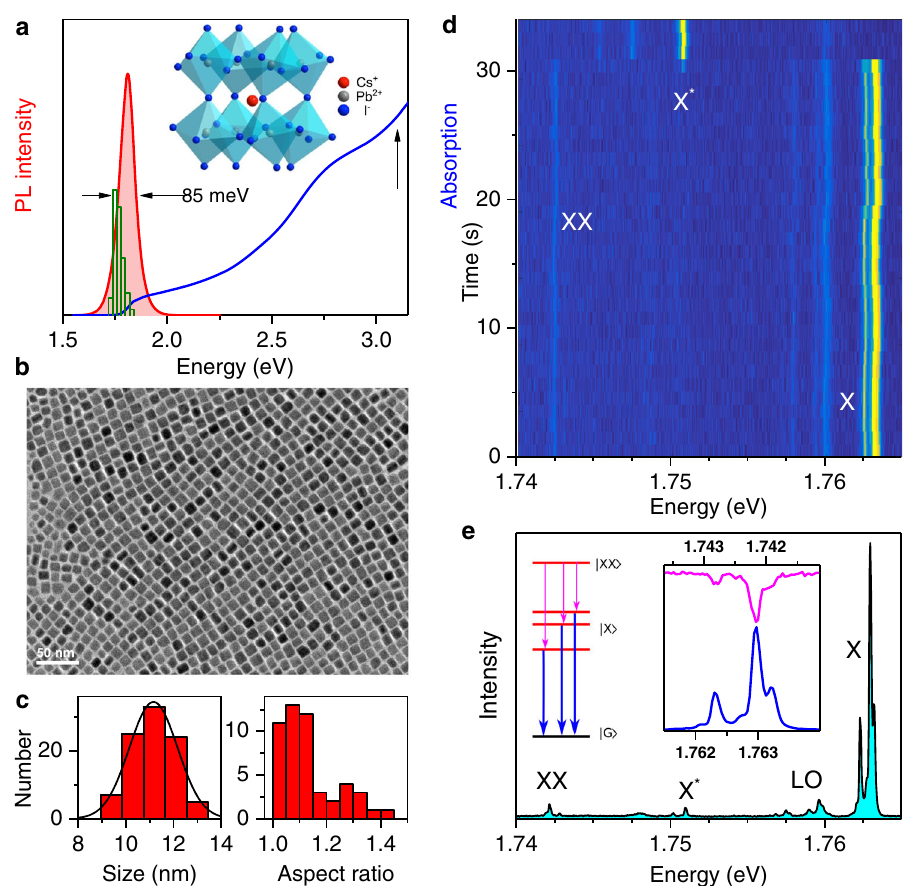
Fig. 1 Structural and optical characteristics of CsPbI 3 perovskite NCs. a Orthorhombic perovskite crystal structure of CsPbI 3 NCs. Room-temperature absorption and PL spectra of an ensemble of CsPbI 3 NCs dispersed in hexane. The vertical arrow at 3.1 eV indicates the excitation energy chosen for the acquisition of this PL spectrum. The width (FWHM) of the PL spectrum is ~85 meV. The green histogram displays the distribution of emission energies of 58 single NCs at 4 K. b Annular bright- fi eld scanning transmission electron microscopy image of CsPbI 3 NCs. c Size histogram (left panel) and histogram of aspect ratios (right panel) for these NCs. The black curve is a Gaussian distribution centered at 11.2 nm, with a full-width at half-maximum (FWHM) of 2.4 nm. The mean aspect ratio is 1.13. d Spectral trajectory of a single NC at 4 K, built with 33 consecutive PL spectra recorded over 1 s at an excitation intensity of ~50 W cm − 2 . It shows a spectral jump together with a change of spectral structure associated to a transition between exciton emission and trion (charged exciton) emission. e PL spectrum of the same single NC at 4 K, integrated over 57 spectra of 1 s extracted from d . It displays the spectral fi ngerprints of the exciton (X) band-edge exciton fi ne structure with its LO-phonon replica, trion (X*) and biexciton (XX) emissions. The correspondence between the XX and X multiplets is shown in the inset. As depicted in the energy level diagram, the transition lines connect the bright biexciton state |XX> with zero angular momentum to the non-degenerate exciton triplet |X>, and the latter to the NC ground state